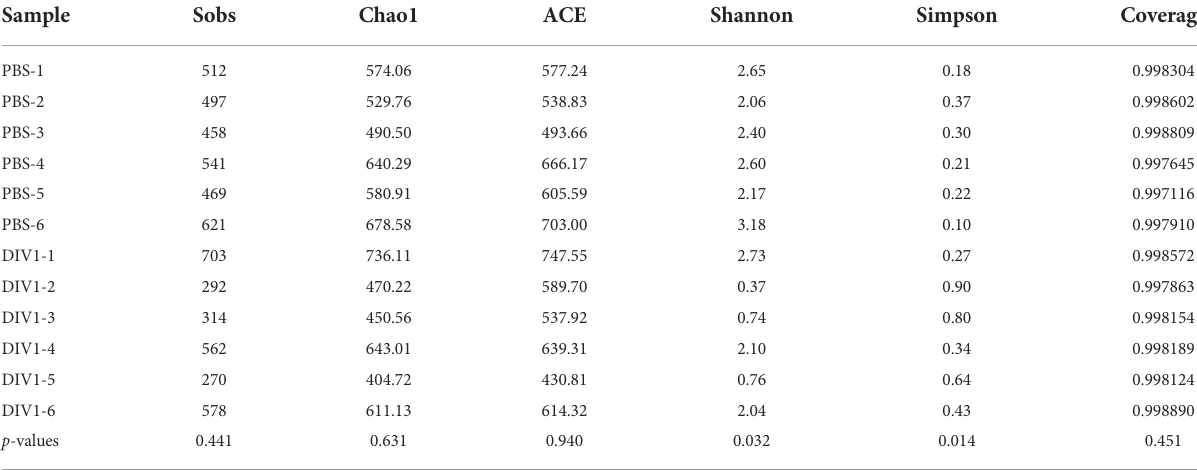
TABLE 1 Alpha diversity index analysis in the PBS-injected group and the DIV1-infected group. Sample